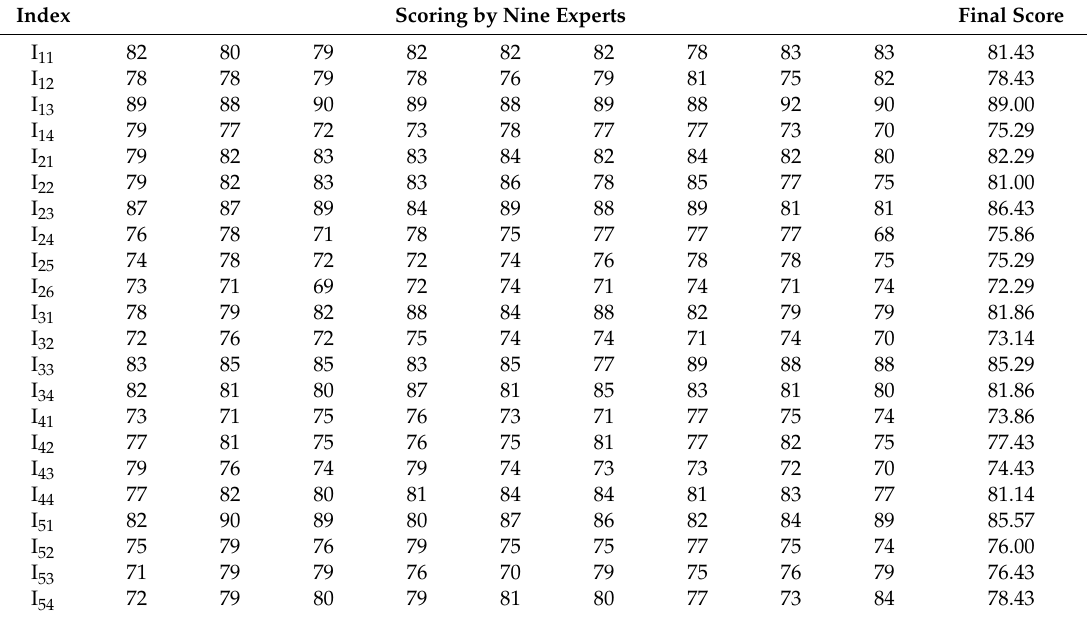
Table 3. Construction safety risk assessment index value of TY dormitory building renovation